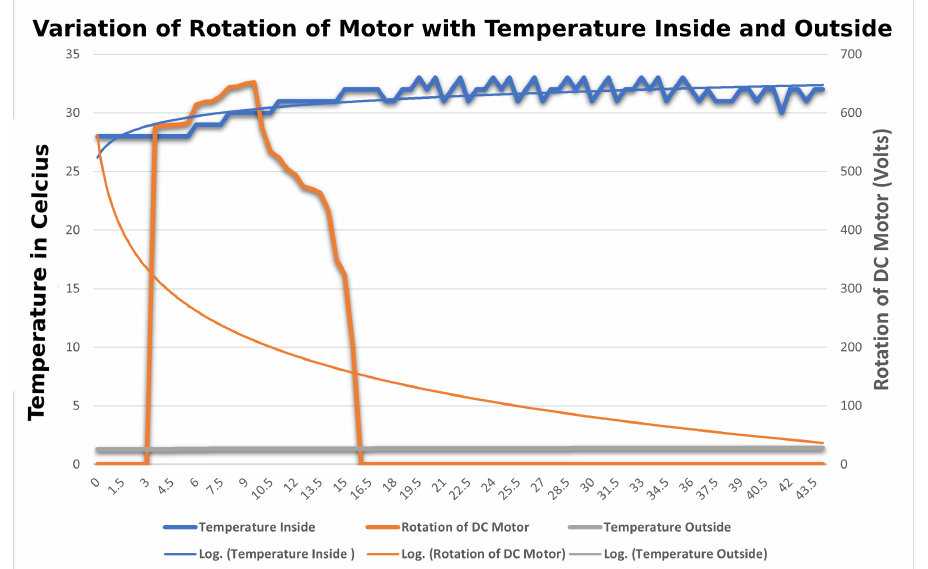
Figure 23. Variation of rotation of motor with the temperature inside and outside the